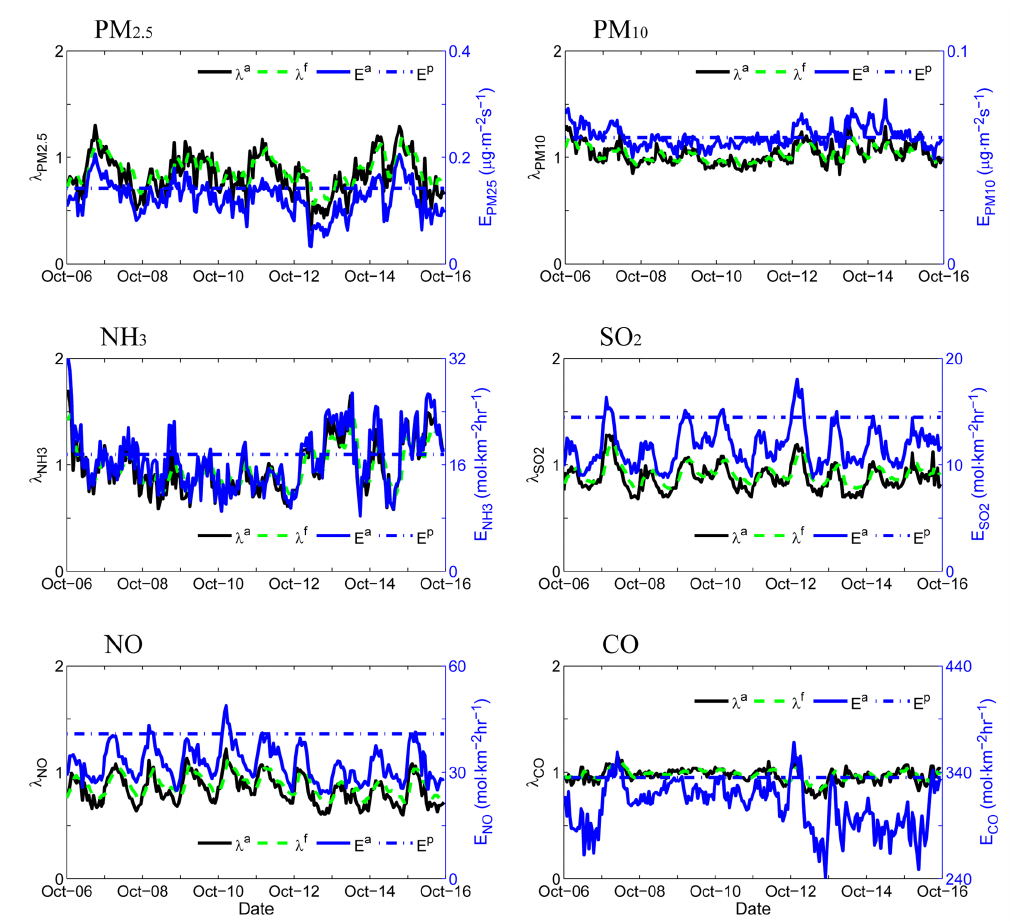
Figure 10. Hourly area-averaged time series extracted from the analyzed emission scaling factors (black line), the forecast emission scaling factors (green dashed line), the analyzed emissions (blue line), and the prescribed emissions (blue dashed line) in the Beijing–Tianjin–Hebei region. Units for PM 2 . 5 and PM 10 emissions: µgm − 2 s − 1 ; units for NH 3 , SO 2 , NO, and CO emissions: molkm − 2 h − 1